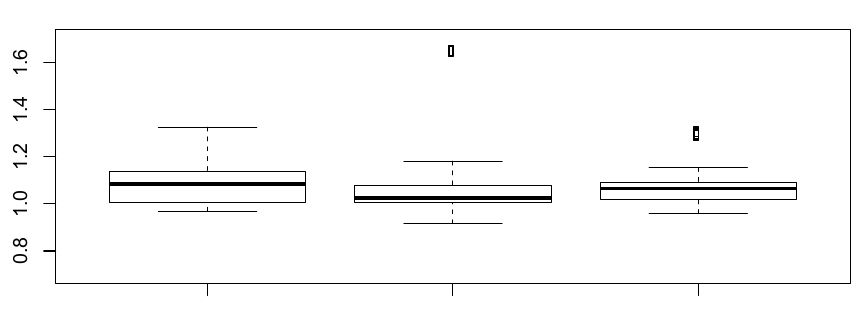
Figure 2. Averaged spectra in healthy human subjects acquired from the buccal mucosa, posterior oropharynx, and trachea.